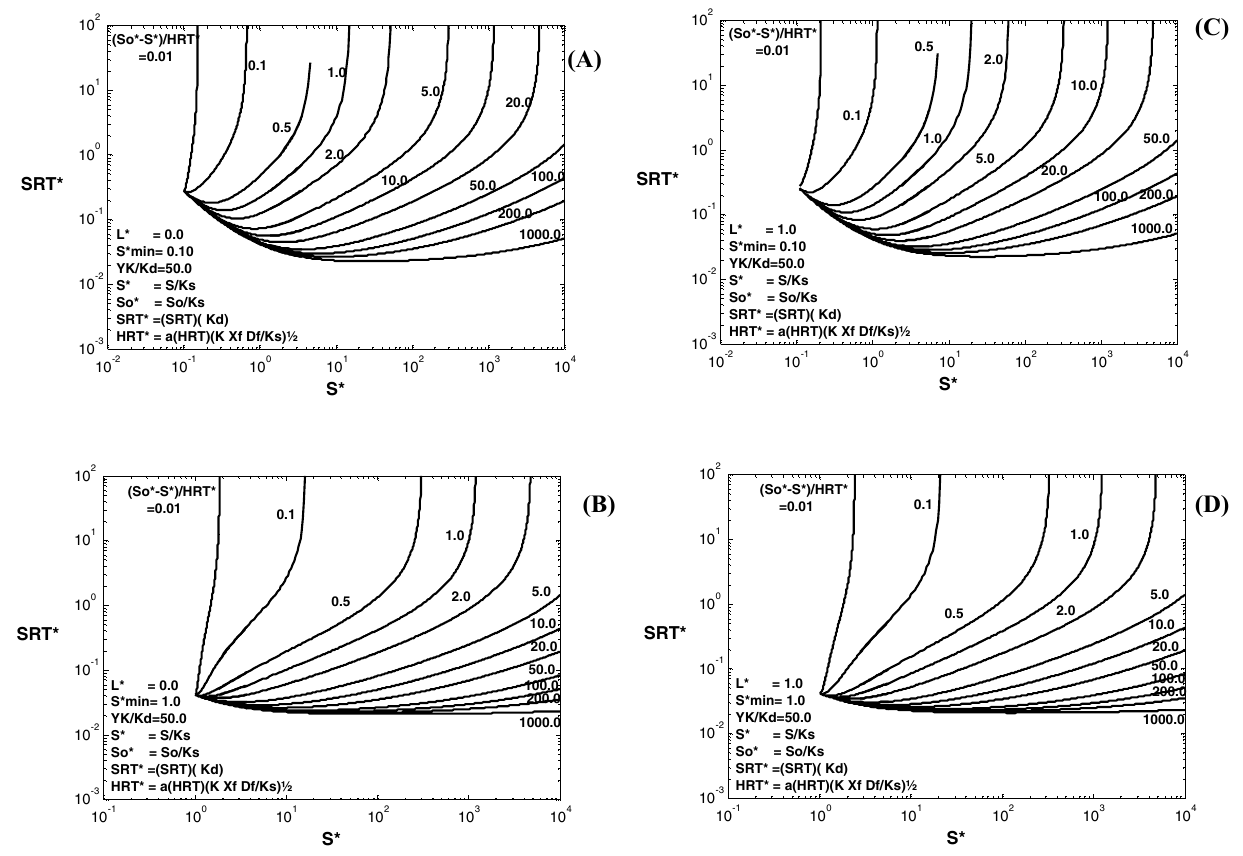
Fig. 6 SRT * as a function of S * and ( S ∗ o − S )/HRT at Y K / K L * = 1.0, S ∗ min =